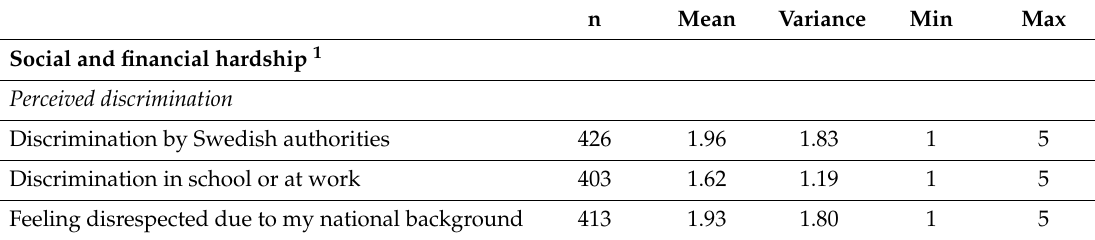
Table 2. Descriptive statistics on indicator variables used in structural equation modelling (SEM) analyses. ESSI: ENRICHD Social Support